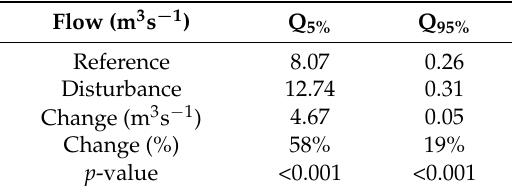
Table 5. Average high flow variable (Q 5% ) and low flow variable (Q 95% ) in the reference and disturbance periods using the paired-year